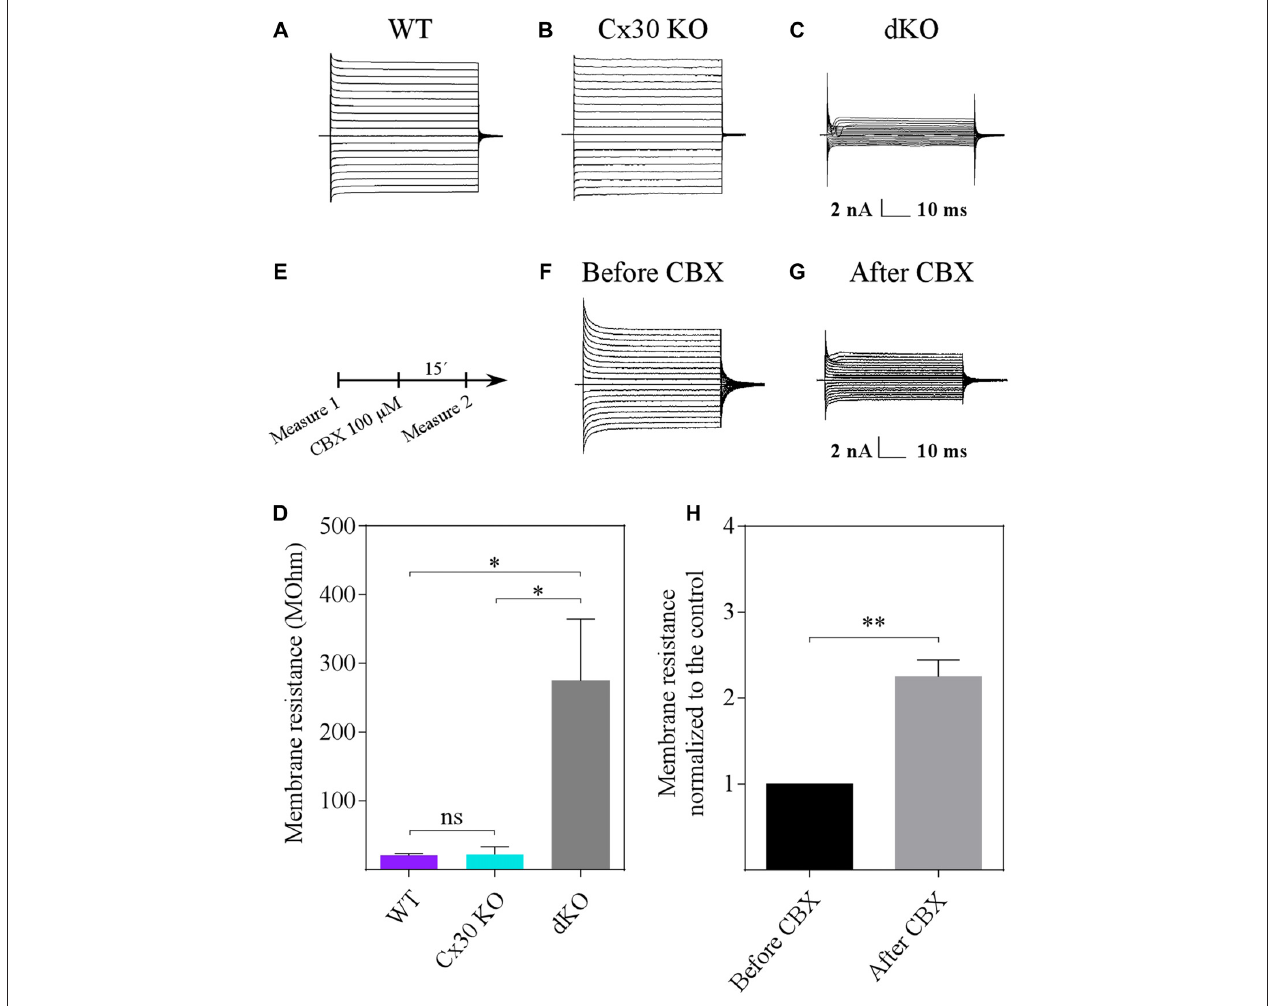
FIGURE 6 | Loss of gap junction coupling affects the current pattern of α -tanycytes. (A–D) Compared to WT cells (A,D) , deletion of Cx30 did not affect the input resistance (determined at –80 to − 70 mV) of α -tanycytes (B,D) , while deletion of Cx43 and Cx30 (dKO) led to a significant increase in the resistance (C,D) . (E–H) Decreasing gap junction coupling pharmacologically also entailed an increase in input resistance. The non-selective gap junction blocker carbenoxolone (CBX) was applied as indicated in (E) . After control recordings in normal artificial cerebrospinal fluid (aCSF) solution (F,H) , CBX (100 µ M) was added (15 min), leading to a significant increase in input resistance (G,H) ( N = 4 animals and 12 slices; data are represented as means ± SEM; Student’s t -test). ∗ P < 0.05, ∗∗ P < 0.01, ns, not